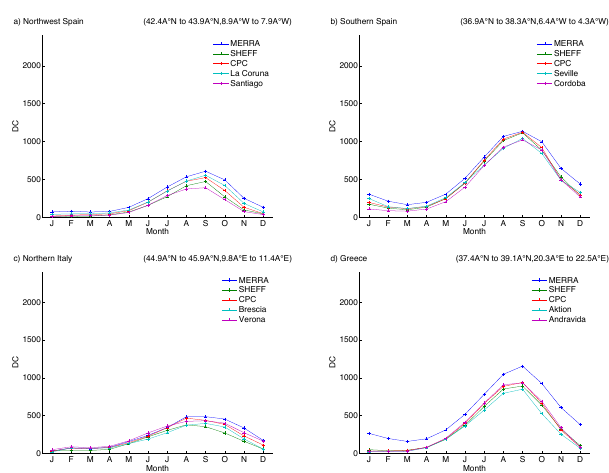
Figure 5. Monthly mean DC for four regions in southern Europe. MERRA, SHEFF and CPC DC are from the GFWED gridded fields over the latitude and longitude range specified in the caption. The other two DC plots are for representative weather stations in that